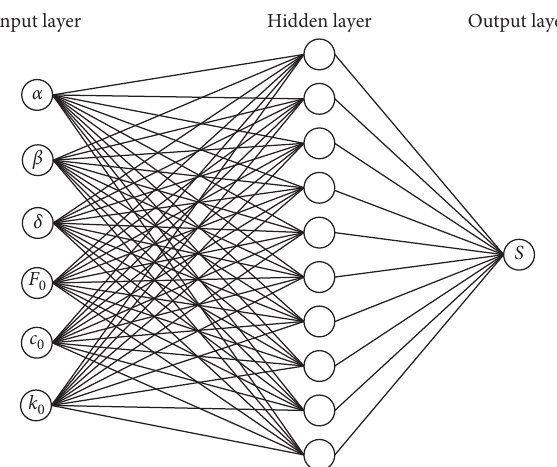
Figure 10: The neural network